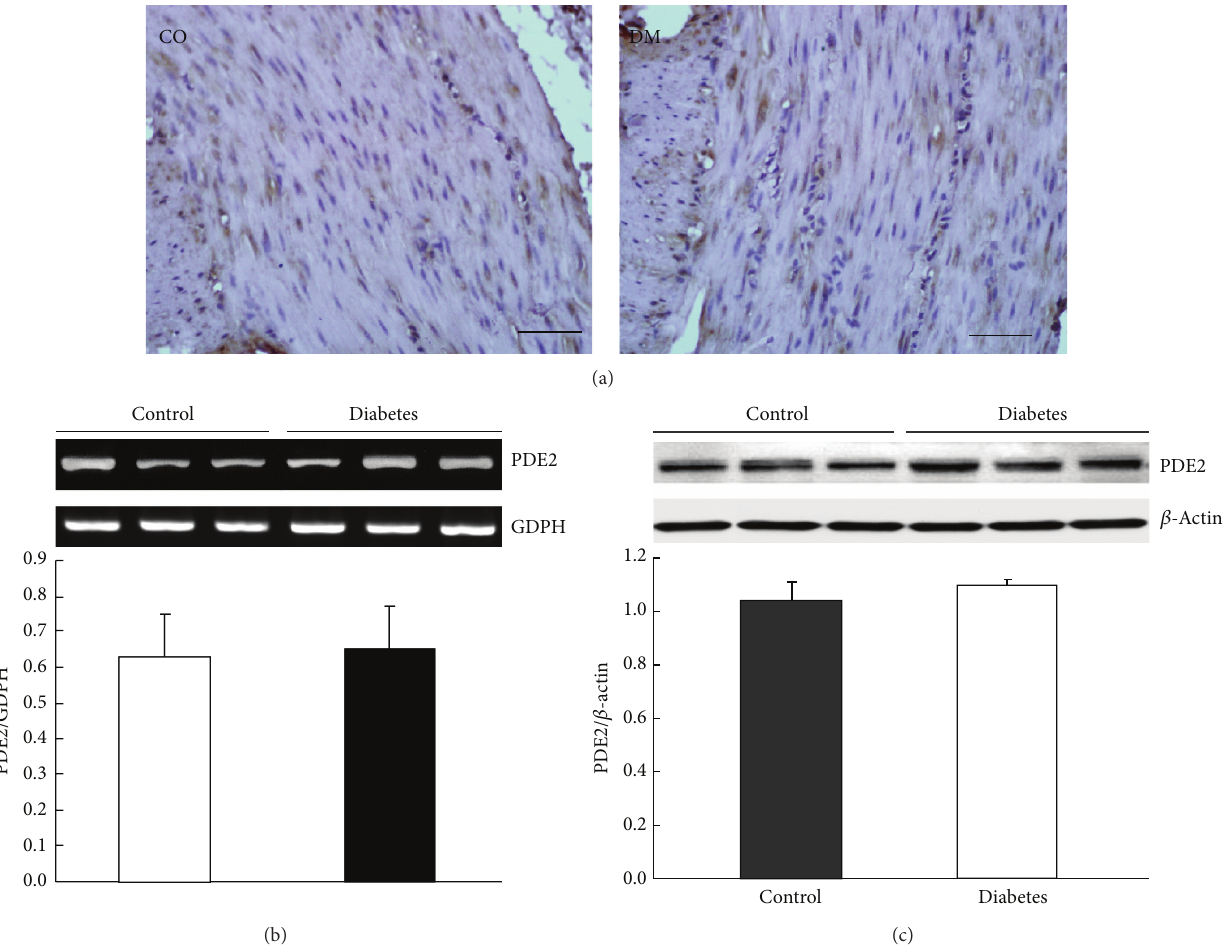
Figure 3: Expression of PDE2 in the gastric smooth muscle. (a) PDE2 immunoreactivity in gastric smooth muscle was not different between the diabetic rats and controls (bars = 20 𝜇 m). (b) The mRNA level of PDE2 in the gastric smooth muscle was not different between diabetic rats and controls ( 𝑛 = 9 , 𝑃 > 0.05 ). (c) The protein level of PDE2 detected by Western blotting analysis in the gastric smooth muscle was not significantly different between diabetic rats and controls ( 𝑛 = 9 , 𝑃 > 0.05